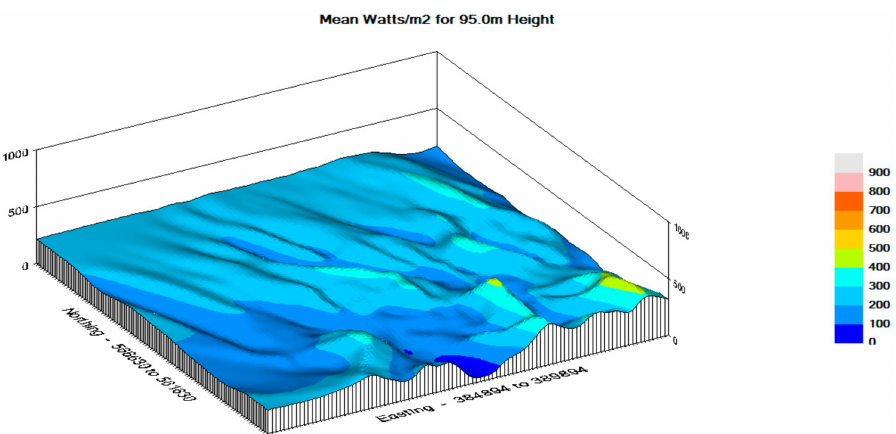
Figure 13. Mean wind speed at KTD site at 95 m above ground level.